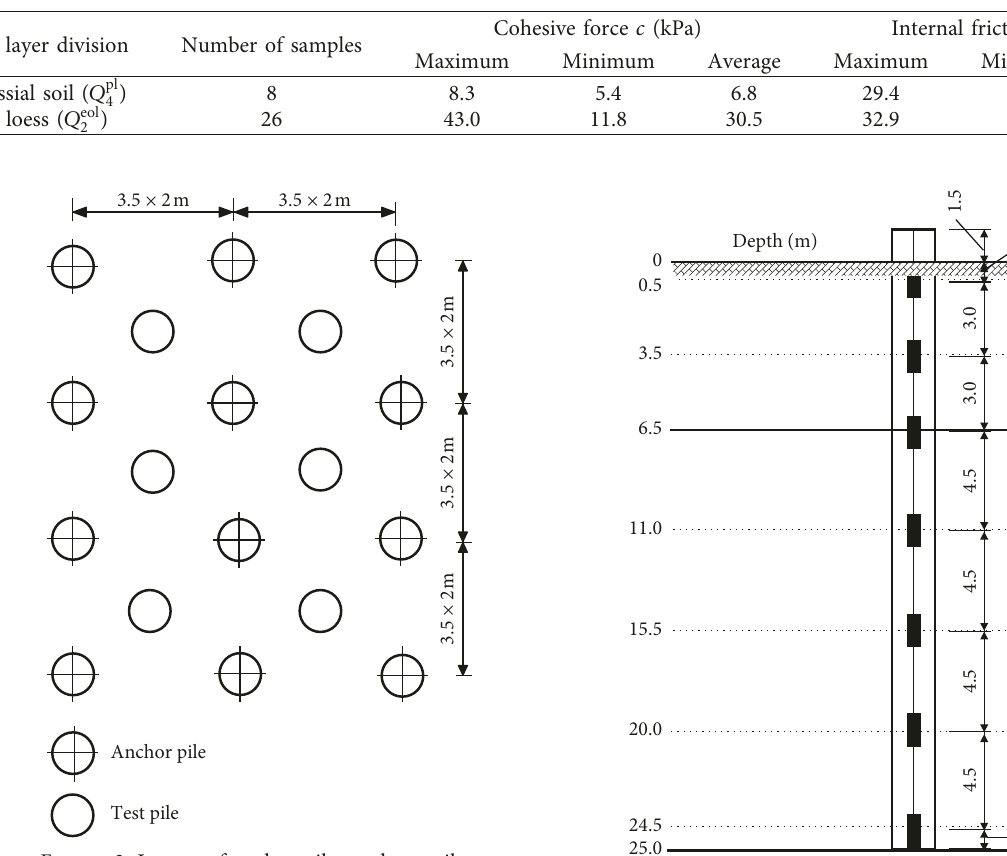
Table 2: Shear strength parameters.